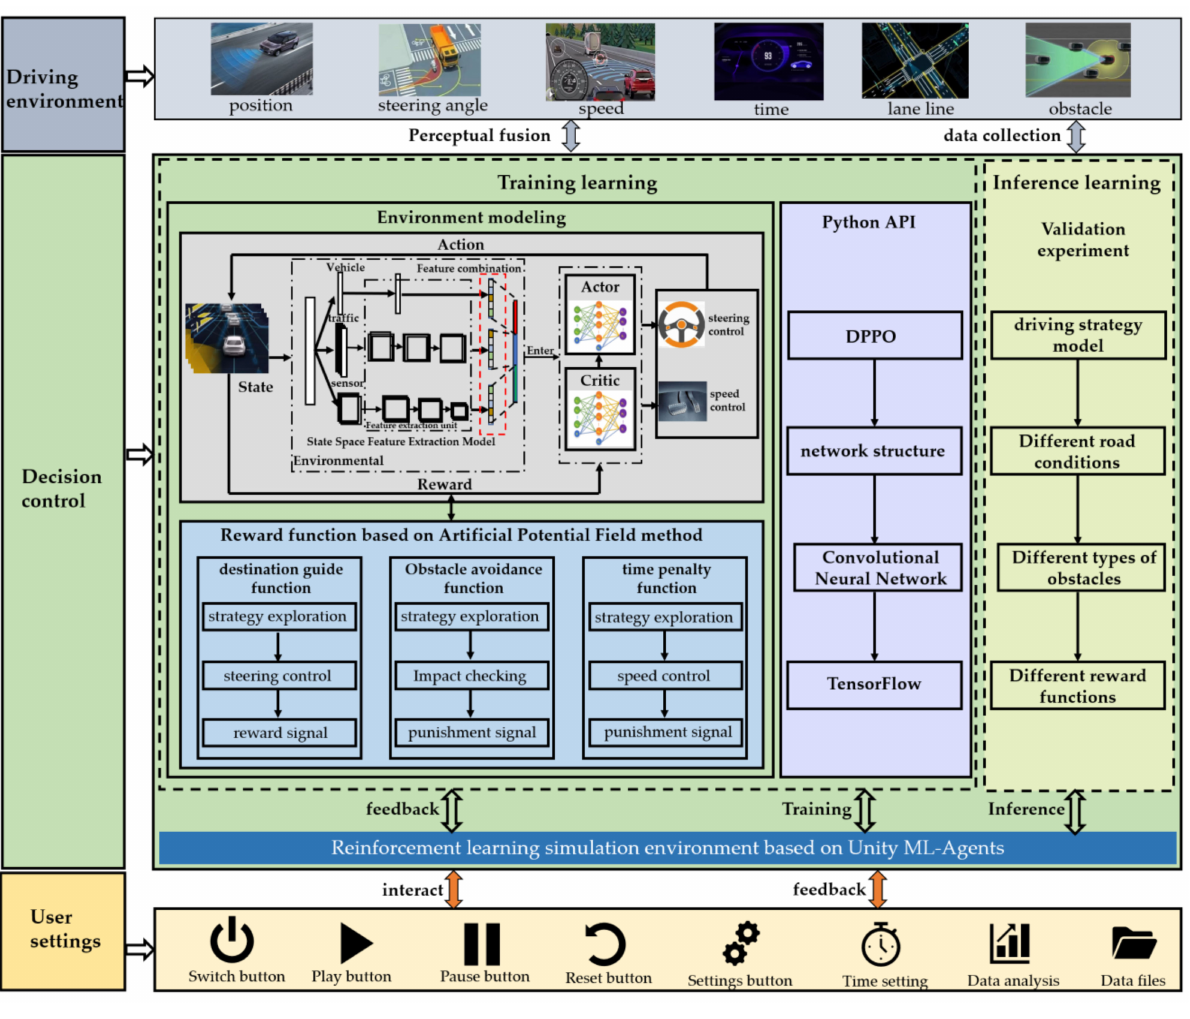
Figure 1. Overall architecture